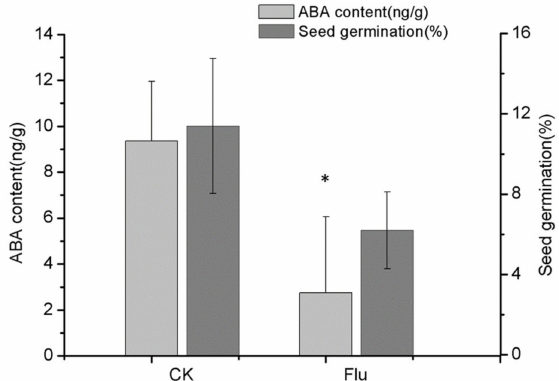
Figure 6. E ff ect of fluridone (Flu) on ABA content and asymbiotic germination of mature seed in P. armeniacum . The seeds were harvested at 124 DAP and used to represent the germination performance of mature seeds under reduced endogenous ABA level. n = 3; ± SD; an asterisk indicates a significant di ff erence from the WT (Student’s t test, p <